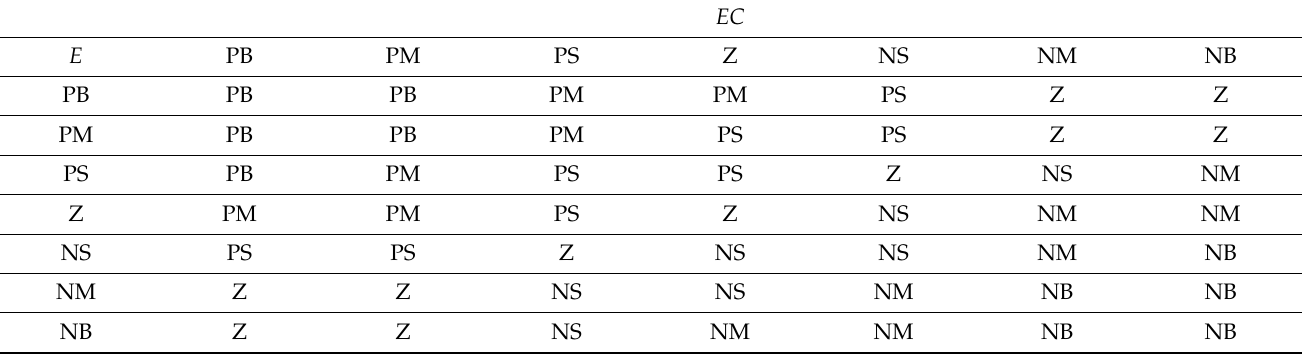
Table 4. Adjustment table of Ki control rule.